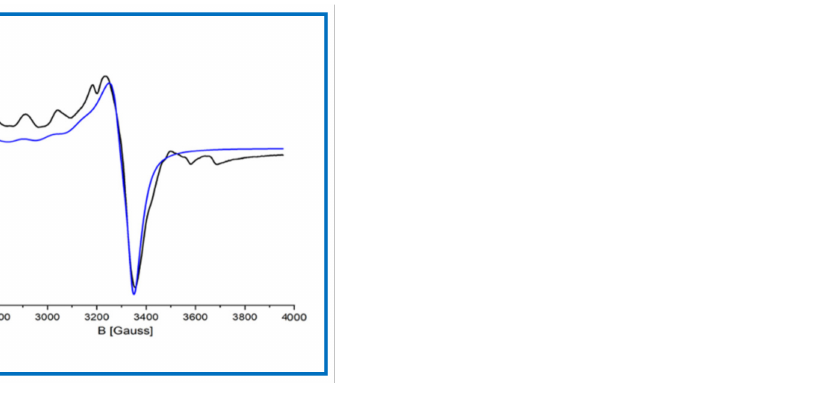
Figure 9. The EPR spectrum of frozen MeOH solution of 3 (black) together with the theoretical spectrum